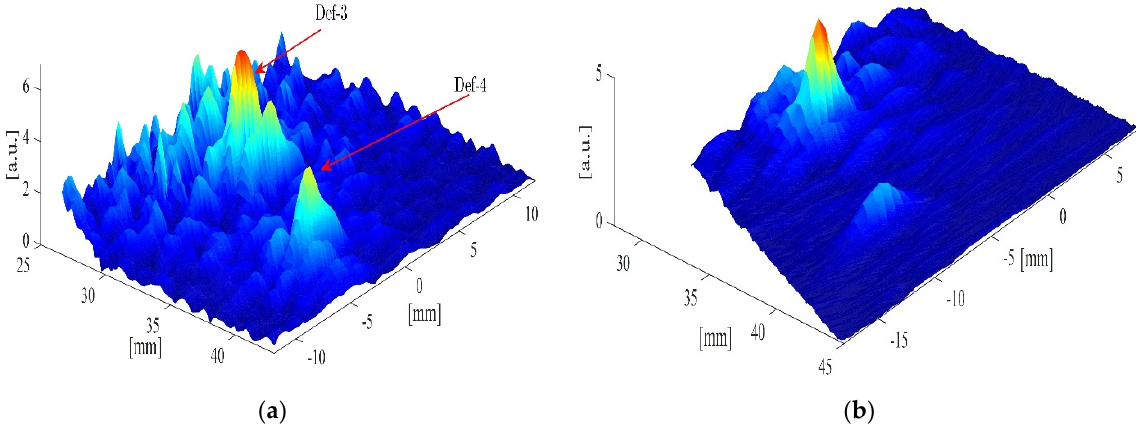
Figure 6. Surface view of a zoom of the sector scan images of Figure 5 . around the location of the defects no. 3 and no. 4. Results of the measurements with ( a ) pulse-compression and ( b ) pulse-echo systems.